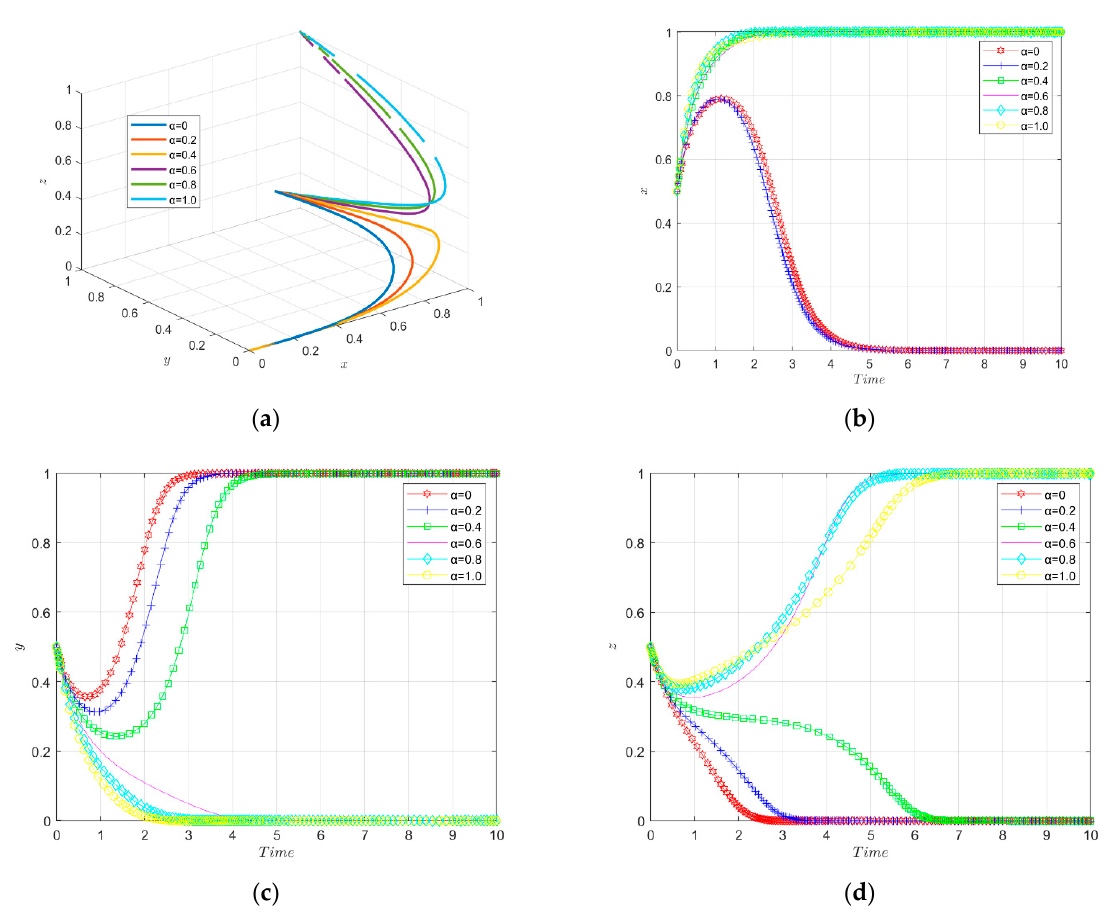
Figure 9. ( a ) Triadic evolutionary trajectory under α changes. Evolutionary trajectories of enterprises ( b ), government ( c ) and financial institutions ( d ) under different financial support enforcement intensities.